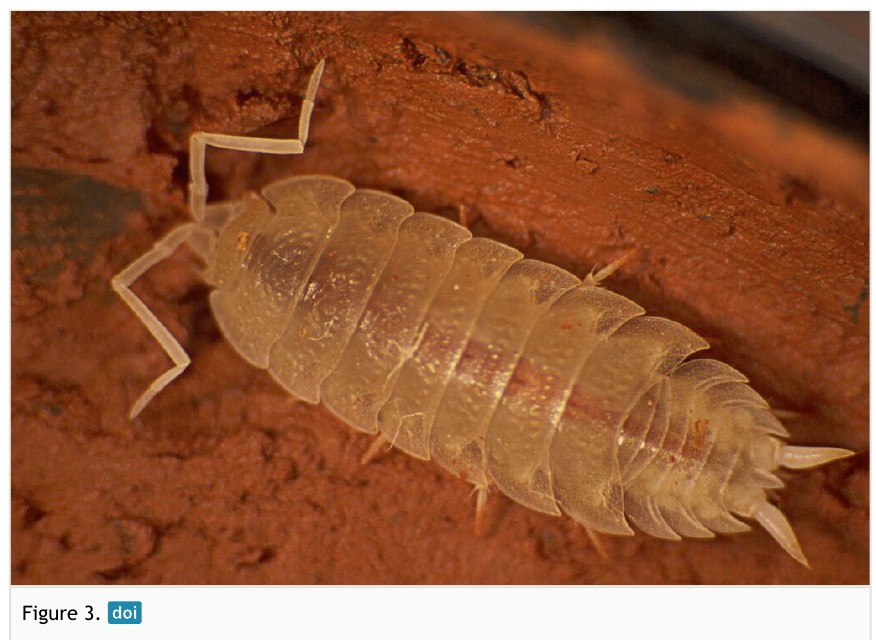
Porcellio cavernicolus Vandel, 1946 from Arrifana Cave in Sicó karst area.